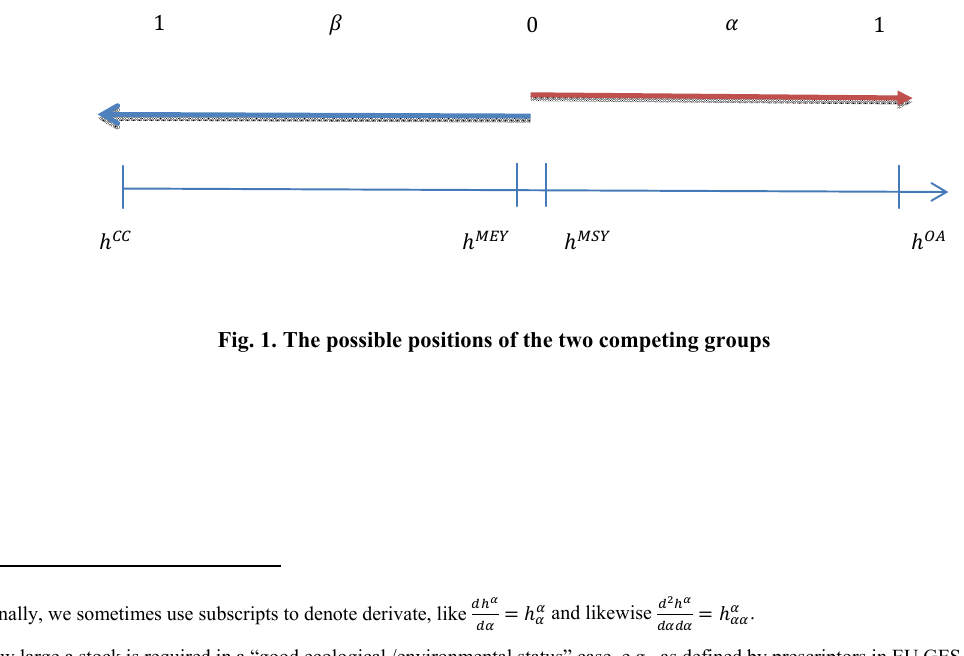
Fig. 1. The possible positions of the two competing groups